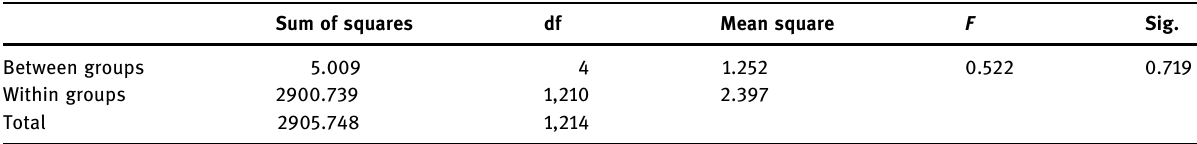
Table 8: Analysis of variance of knowledge level by parents ’ job Sum of